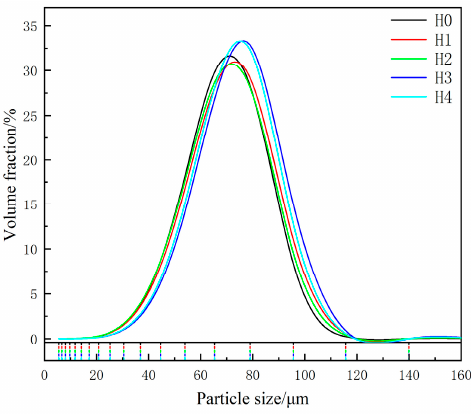
Figure 4. Particle size distribution of recycled powder.